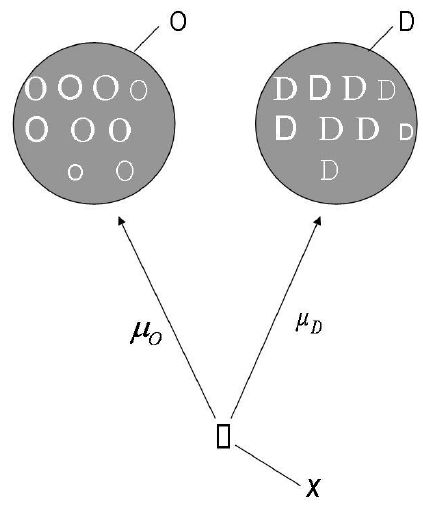
Figure 8. Illustration to Zadeh’s view on pattern classification: the sign (cid:3) (or x , as Zadeh wrote) belongs with membership value, µ O (O), to the “class” of Os and with membership value, µ D (D), to the “class” of Ds.